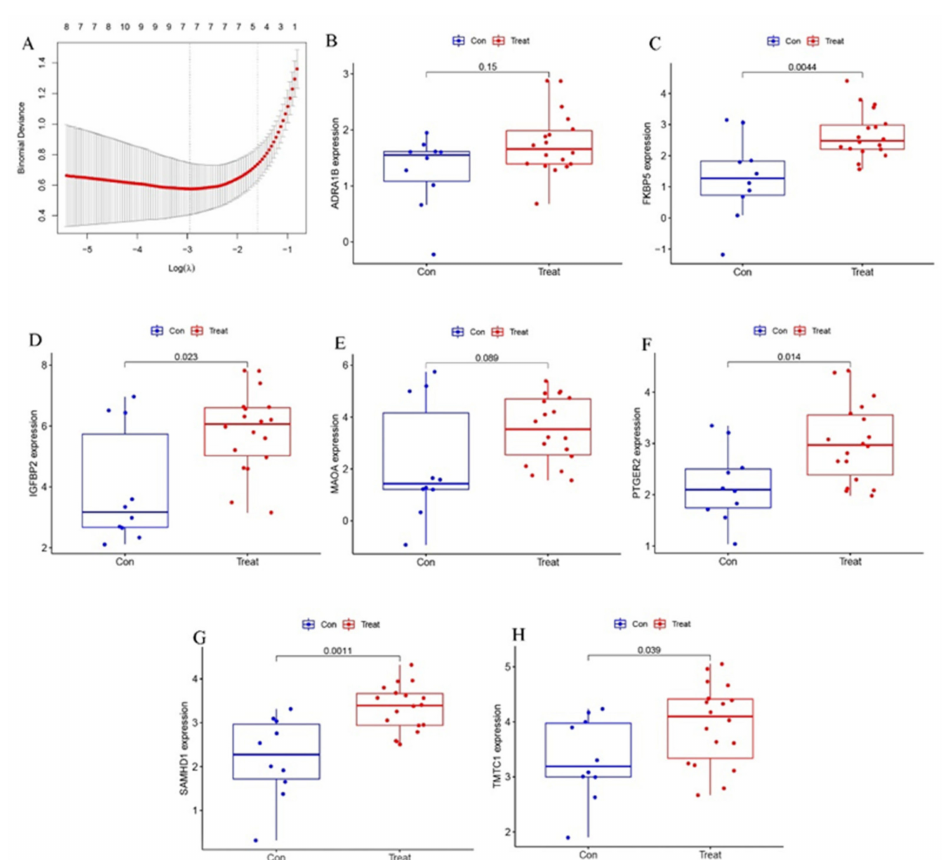
Figure 5. ( A ) The least absolute shrinkage and selection operator (LASSO) logistic regression algo- rithm was used to retain the most predictive features. ( B − H ) The differential expression of ADRA1B ( B ), FKBP5 ( C ), IGFBP2 ( D ), MAOA ( E ), PTGER2 ( F ), SAMHD1 ( G ) and TMTC1 ( H ) in test